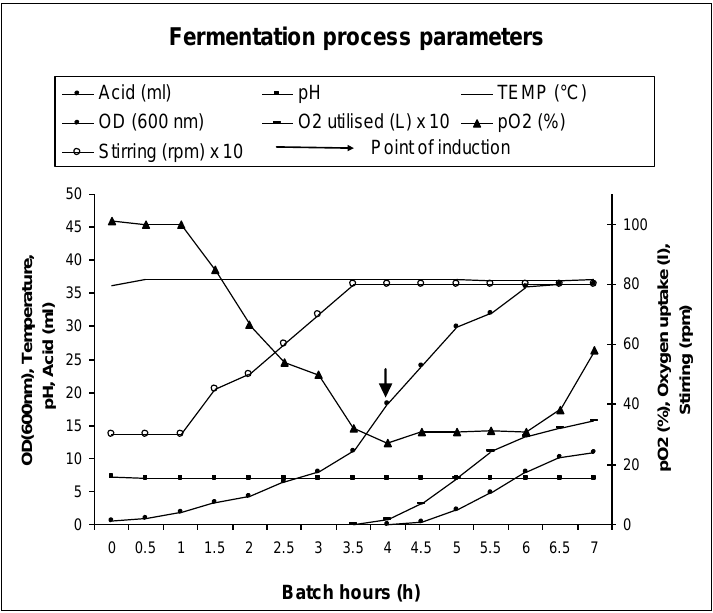
Figure 2. Expression of TRX-hGMCSF in 2 L fermenter in In-house medium. Various fermentation parameters were plotted against the batch hour. The cells were induced with 1 mM IPTG at an OD of 18 and the culture was grown for another 3 h until it reached an 600 OD of 37. 600